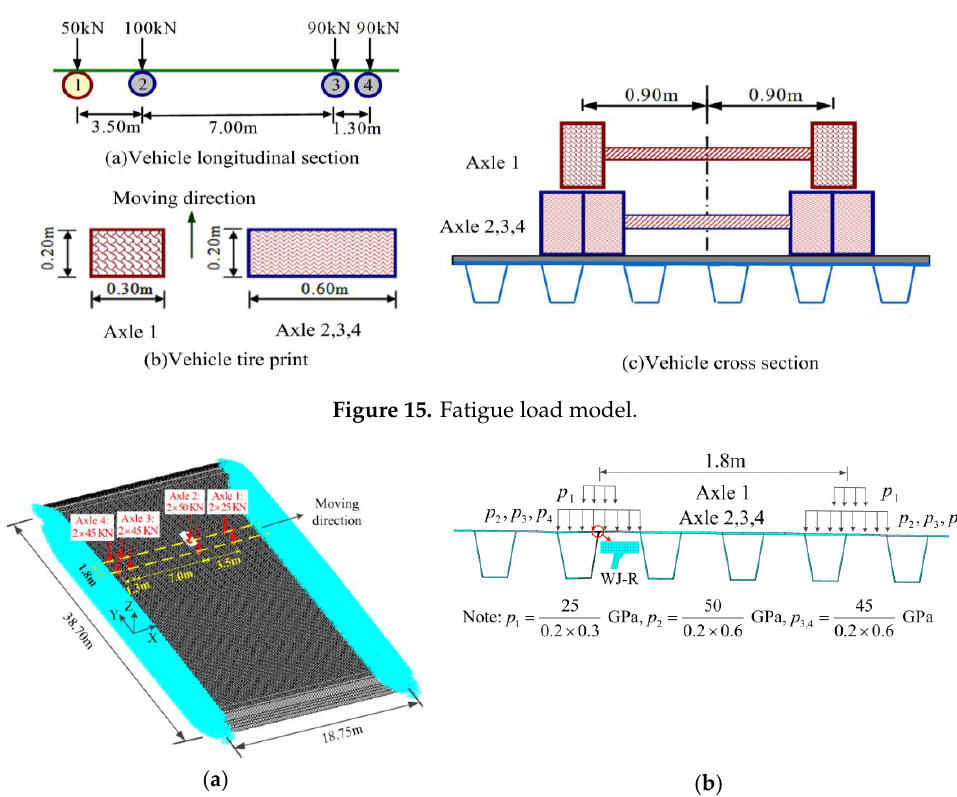
Figure 16. Moving vehicle in the FEM. ( a ) Moving vehicle longitudinal distribution; ( b ) Vehicle transverse distribution.